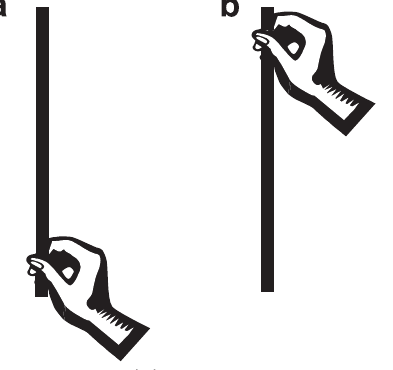
Figure 2. Pendulum in Up and Down Positions (A) Pendulum held in up (unstable) position (B) Pendulum held in down (stable)